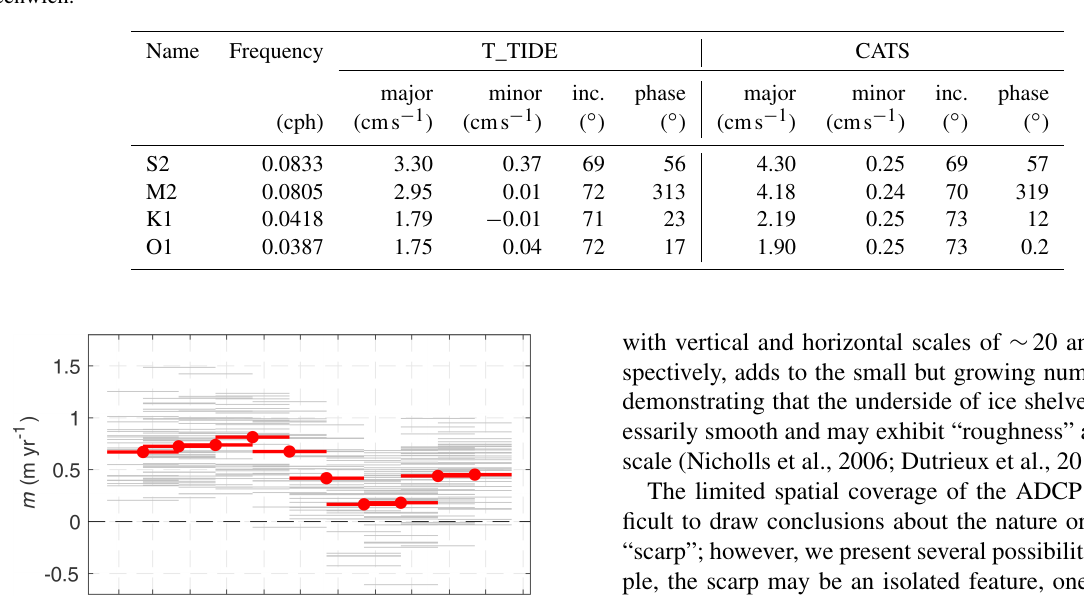
Table 2. Ellipse parameters for tidal current constituents of the depth-mean flow over the upper 90m of the water column from the T_TIDE harmonic analysis (Pawlowicz et al., 2002) and predicted by the CATS2008 tidal model. The parameters are velocities of the ellipse major and minor axes, inclination of the semi-major axis (counter-clockwise from east), and phase of the tidal vector relative to equilibrium tide at Greenwich.